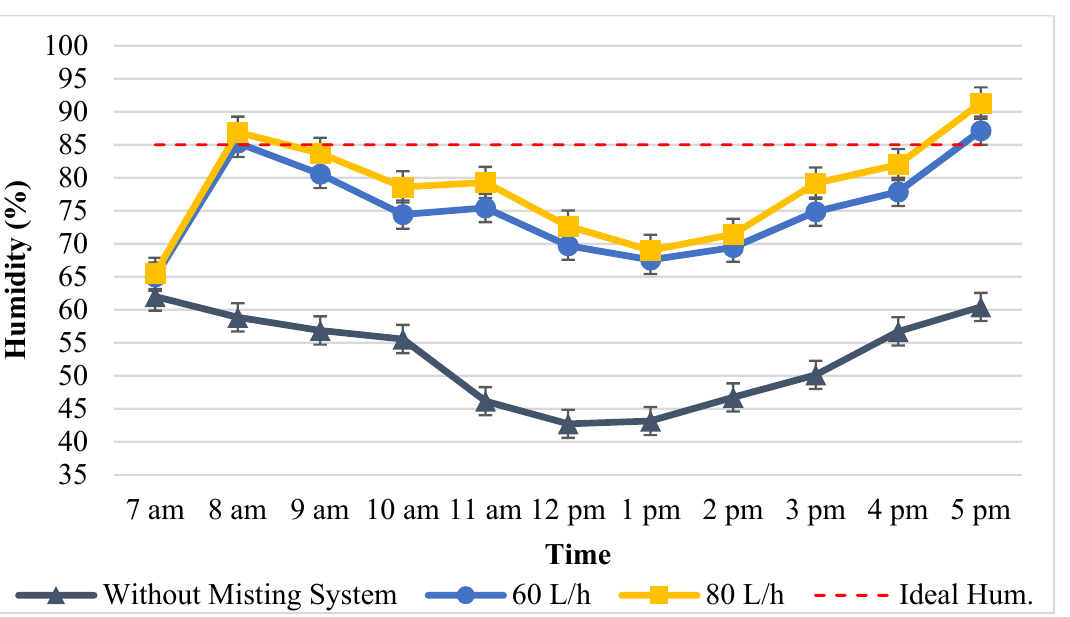
Figure 6. Greenhouse humidity with the misting system mass flow rate of “80 L/h” and “60 L/h”. Figures 5 and 6 show the curve of temperature and humidity in the greenhouse for discharge misting at “80 L/h” and “60 L/h”, respectively. Air temperatures above “33 ◦ C” occur from 10 a.m. to 2.30 p.m. for a discharge of “60 L/h” and from 11.45 a.m. to 2 p.m. for a discharge of “80 L/h”. Meanwhile, humidity that exceeds 85% occurs from 8 a.m. to 8.40 a.m. and above 4.20 p.m. for a discharge of “80 L/h” and 4.45 p.m. for a discharge of “60 L/h”. The volume of water for misting for ten hours from 7 a.m. to 5 p.m., according to Table 4 data, is “803.9 L” for “80 L/h” discharge and “604.8 L” for “60 L/h” discharge. The data show that the greater the misting discharge, the greater the heat absorbed by the mist grains; therefore, the air temperature decreases